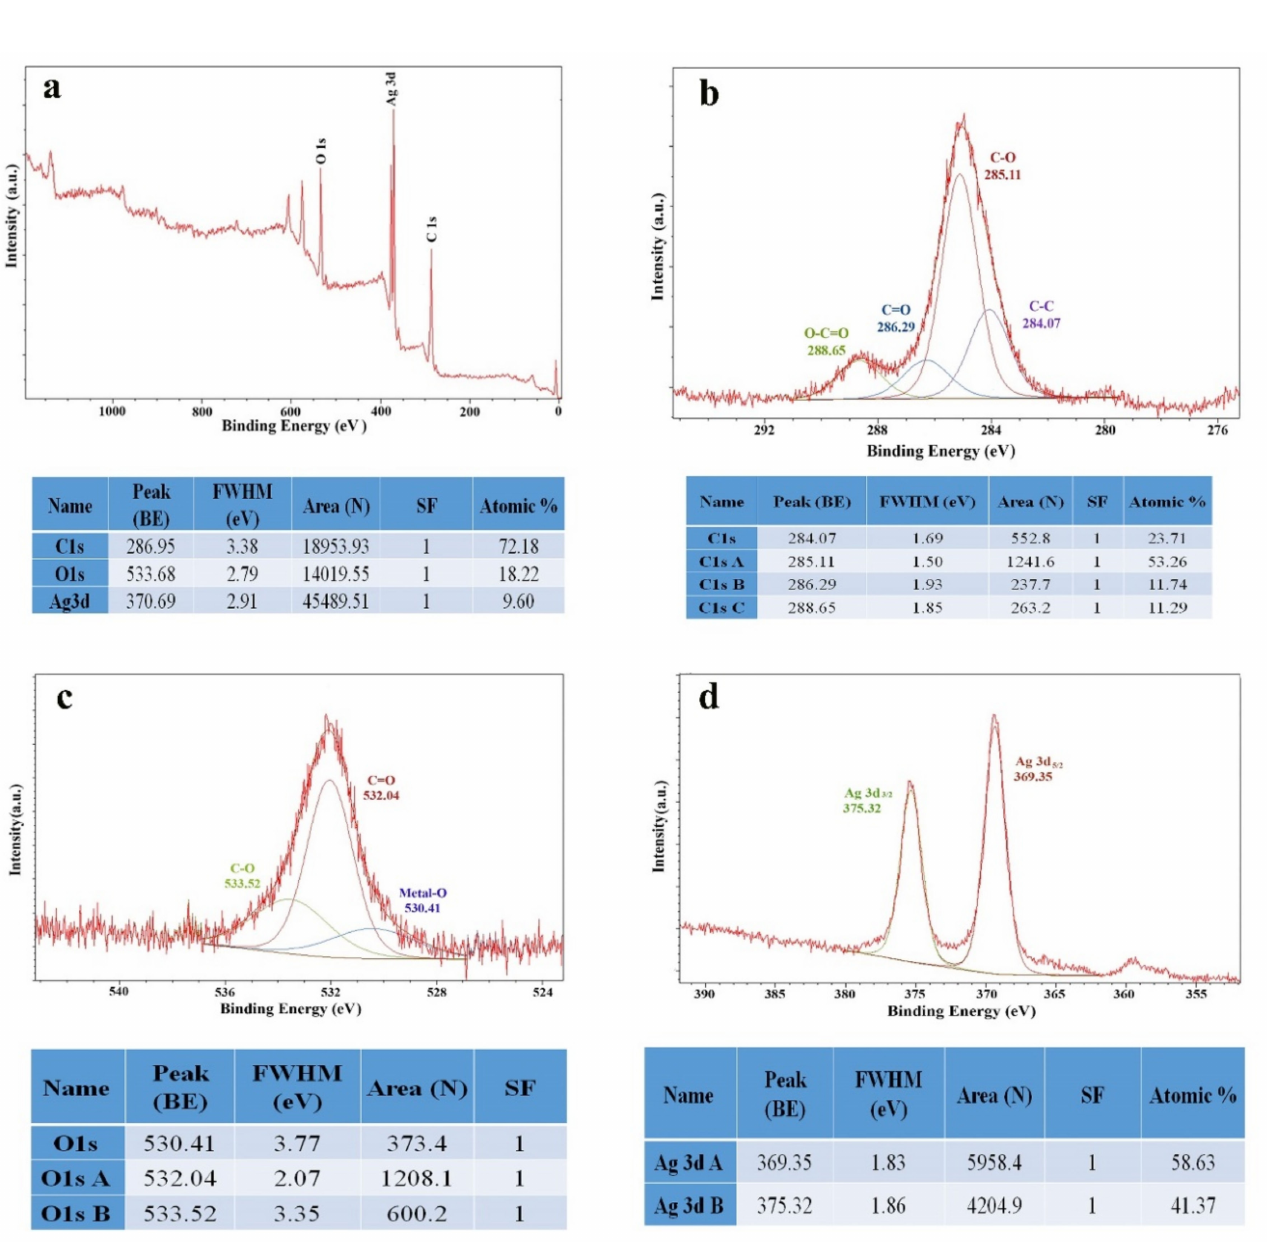
Figure 3. XPS spectra of ( a ) Au@Ag (P); ( b ) C 1s spectrum of Au@Ag (P); ( c ) O 1s spectrum of Au@Ag (P); and ( d ) Ag 3d spectrum of Au@Ag